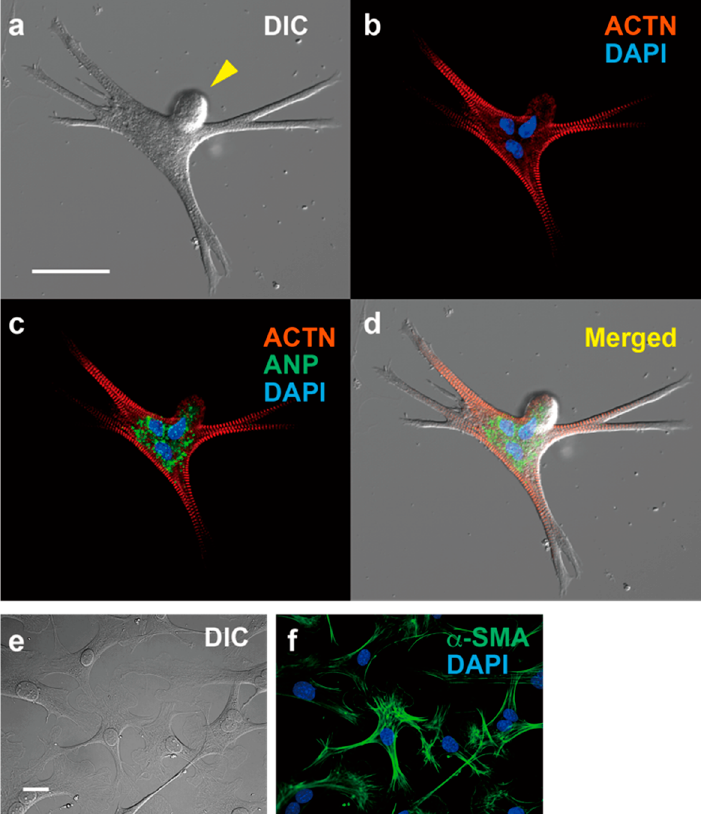
Figure 1. Immunofluorescent microscopy of ACM and cardiac fibroblasts. expressing ACTN and ANP, and cardiac fibroblasts expressing α -SMA. ( a – d ) ACM, bar, 50 µm. ( a ) Differential interference contrast image (DIC). ( b ) Immunostaining for α -actinin (ACTN, red) and DAPI staining for nuclei (blue). ( c ) Merged image for ACTN, DAPI and atrial natriuretic peptide (ANP, green). ( d ) Merged images for ( a – c ). ( e , f ) Cardiac fibroblasts, bar, 50 µm. ( e ) DIC. ( f ) Immunostaining for α -smooth muscle actin ( α -SMA) and DAPI staining.